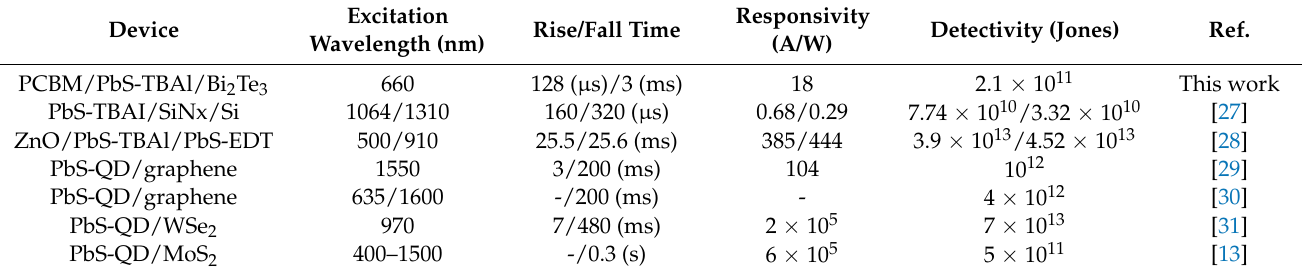
Table 1. List of photodetectors based on PbS QD heterojunctions and their